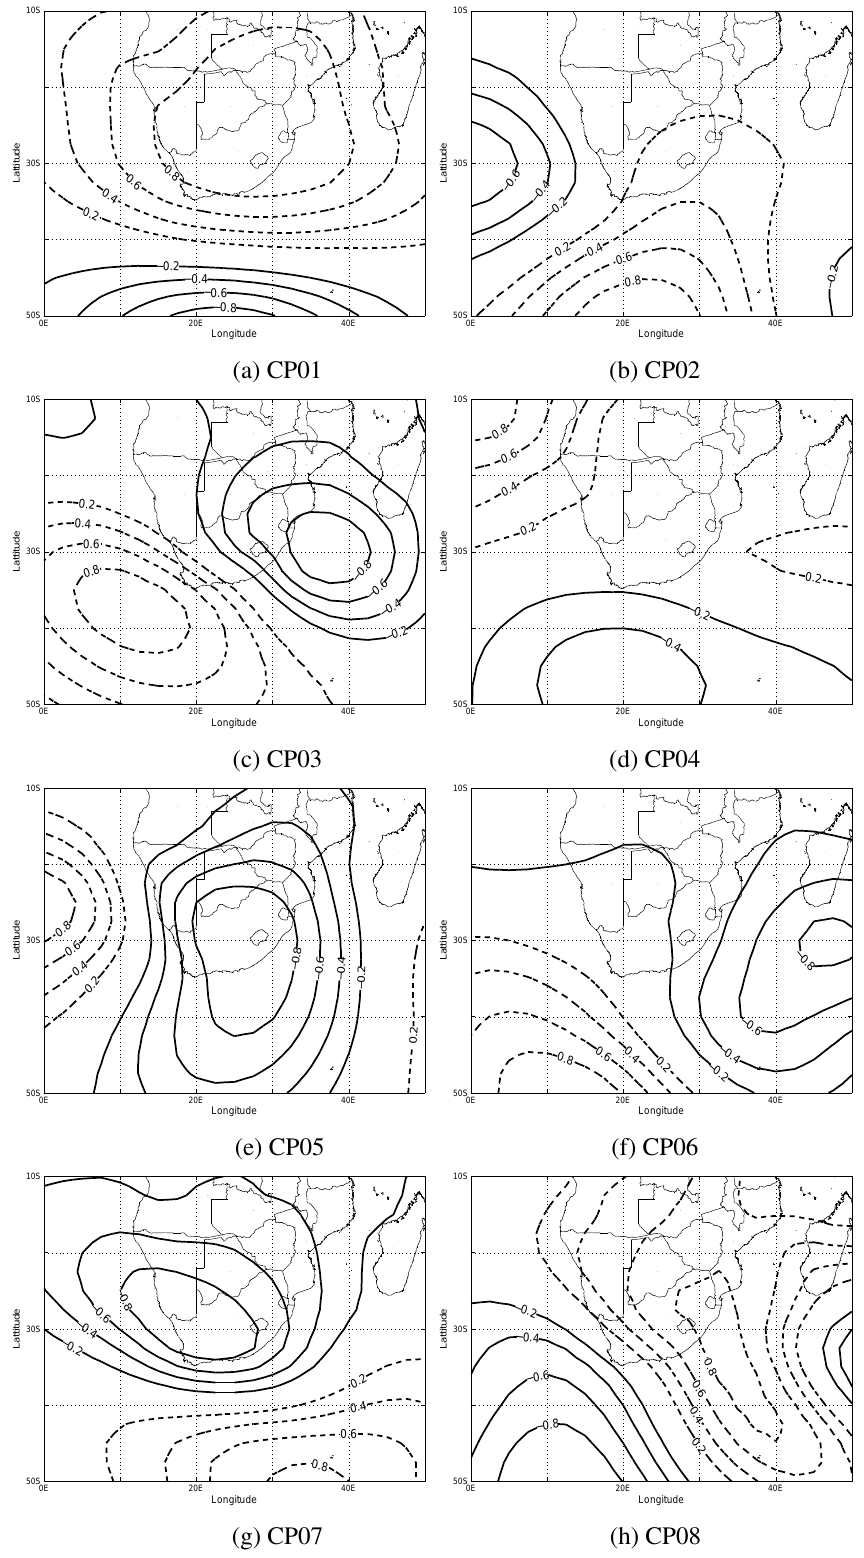
Figure 2. Average anomaly patterns for all CP classes: 1–8. Positive anomaly contours are shown as the dashed line while negative contours are solid.